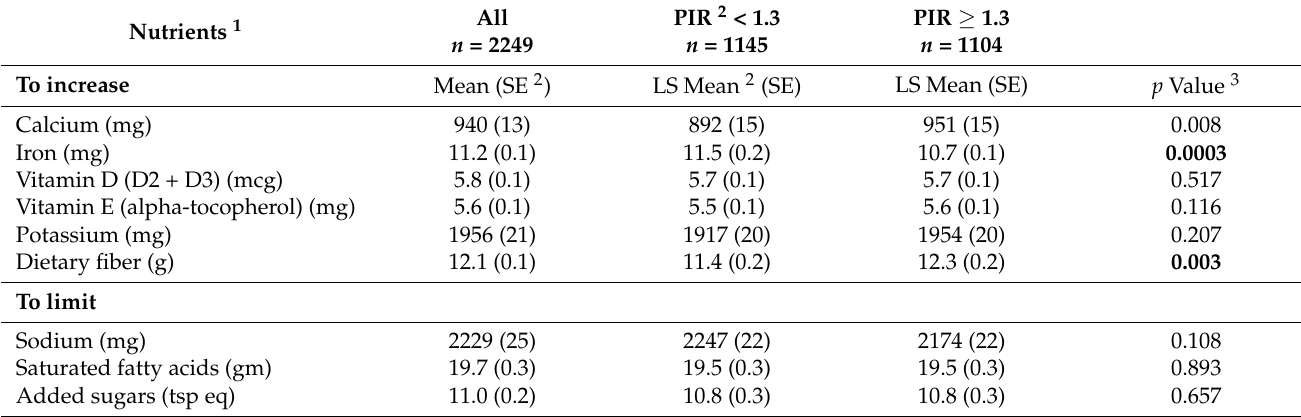
Table 2. Nutrient intakes of children 2–5 years, NHANES (2011–2018) by family income to poverty ratio